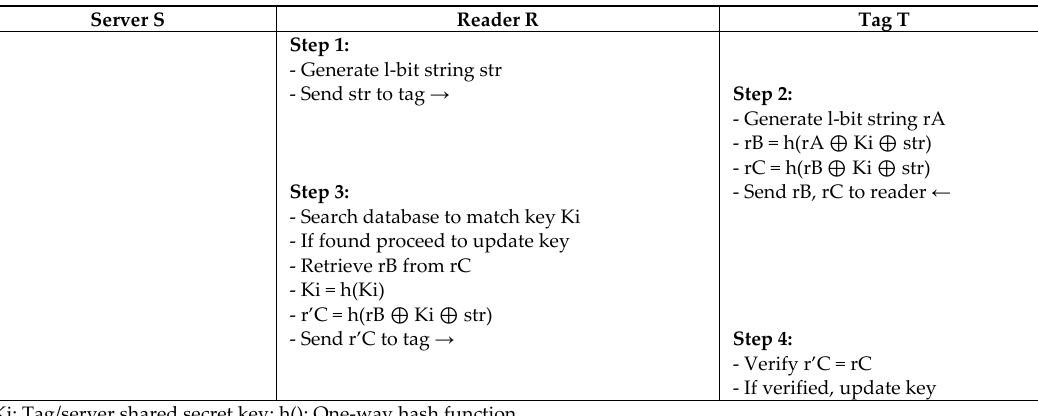
Figure 12. Lightweight Protocol based on Synchronized Secret (MASS) by S. Lee.